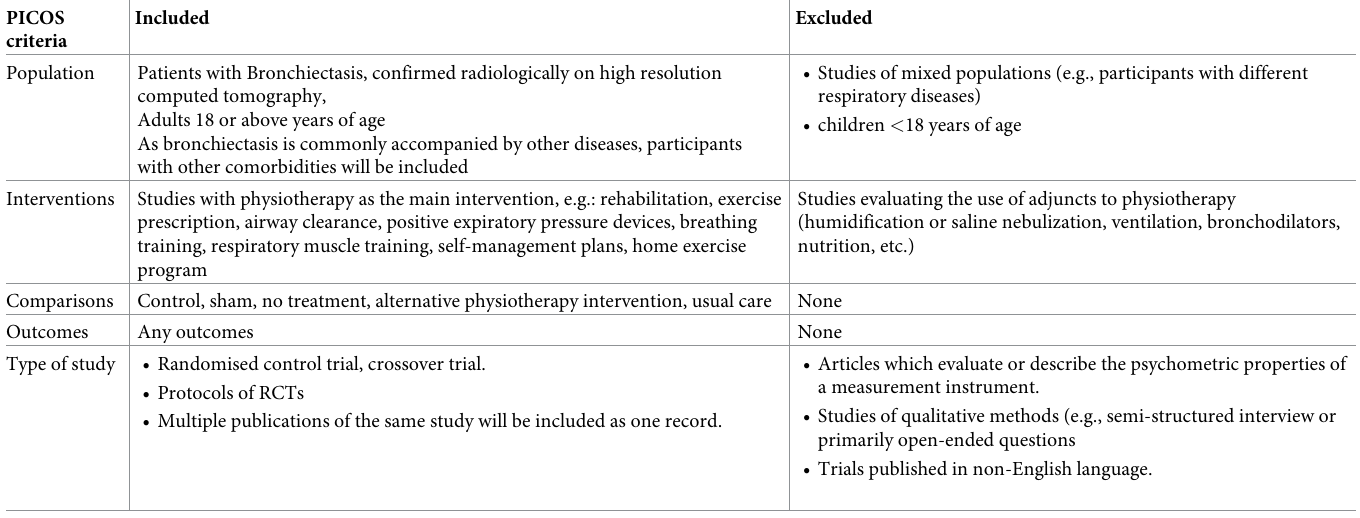
Table 1. Study selection